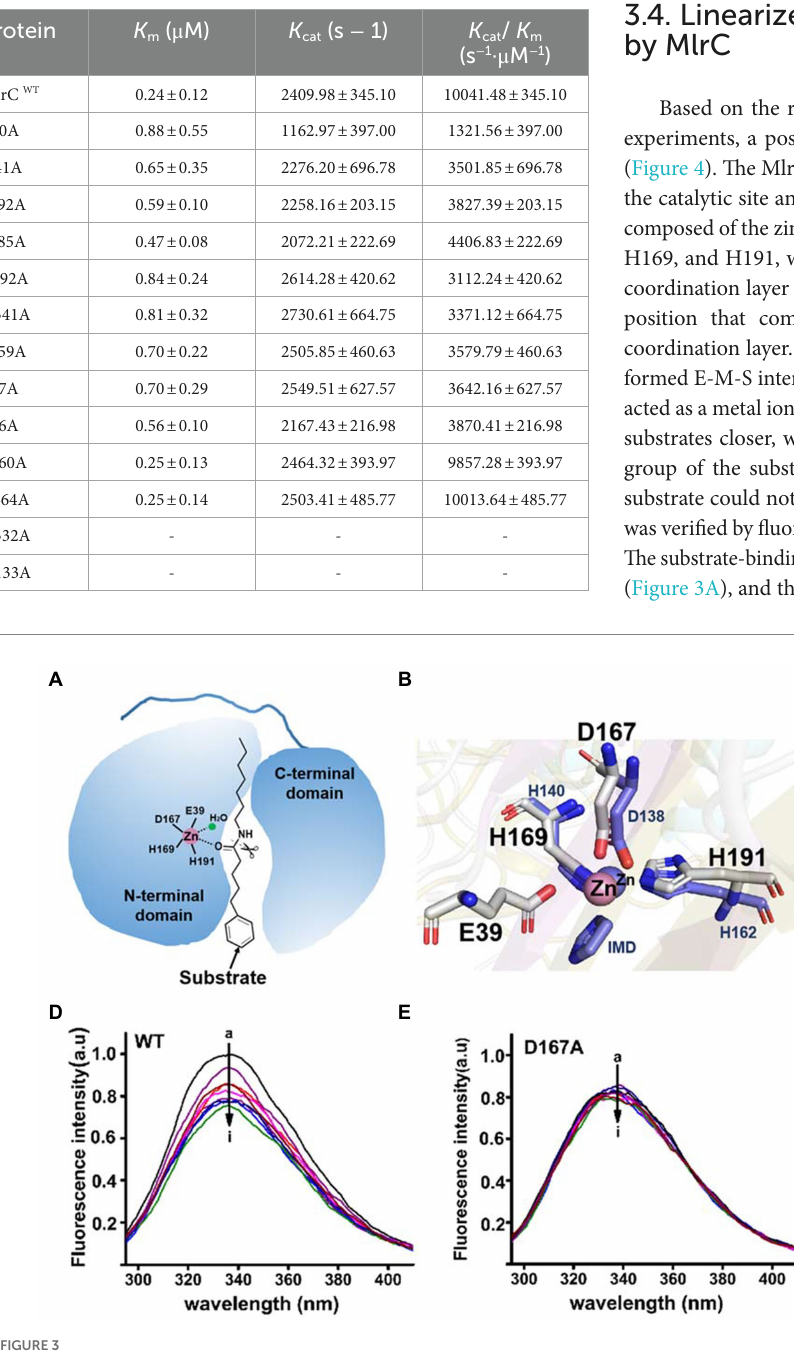
TABLE 1 Kinetic parameters of wild-type MlrC and variants.